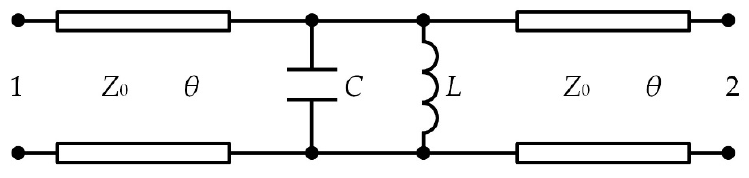
Figure 4. Symmetric E-plane iris equivalent circuit.